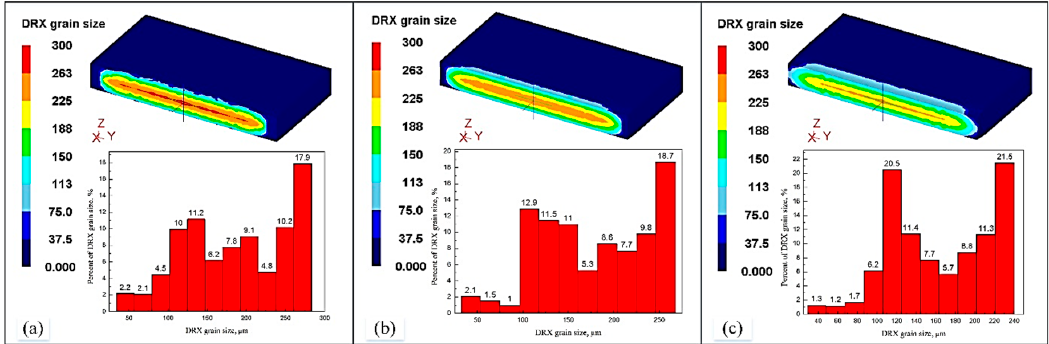
Figure 12. Distribution of DRX grain sizes, and the proportion of different DRX grain sizes: ( a ) 20 mm; ( b ) 30 mm; ( c ) 50 mm.